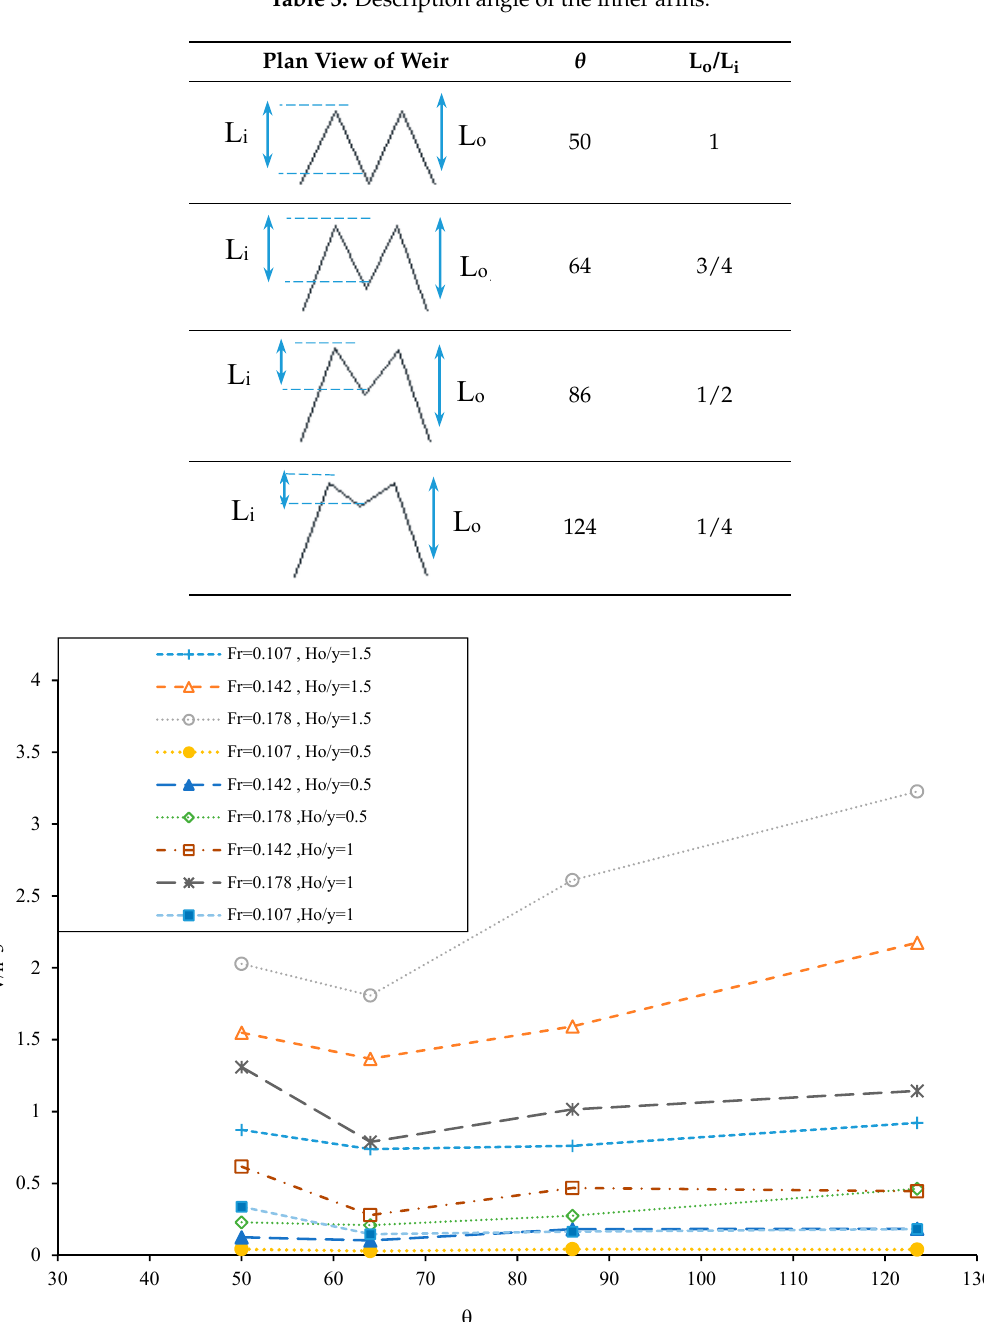
Table 3. Description angle of the inner arms.